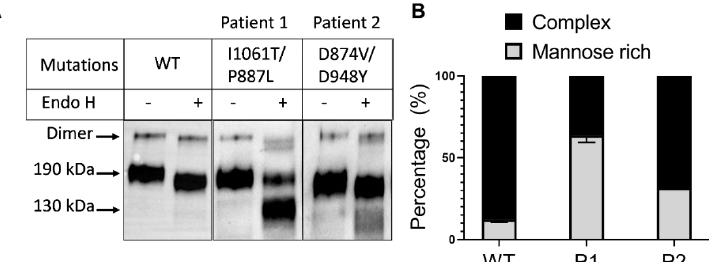
Figure 1. Homogenates were immunoprecipitated with an anti-NPC1 antibody, and the resulting sample was divided into two, one untreated (-) and the second treated with EndoH ( + ). The complex glycosylated EndoH-resistant form of the NPC protein can be seen at 190 kDa and the EndoH-sensitive form at 130 kDa ( A ). Bands corresponding to the complex glycosylated and mannose rich forms of the NPC protein were quantified and are displayed as a percentage of the total ( B ). 2.2. Variable Levels of Lipid Accumulations Correlate with the NPC Mutation and the Trafficking Pattern